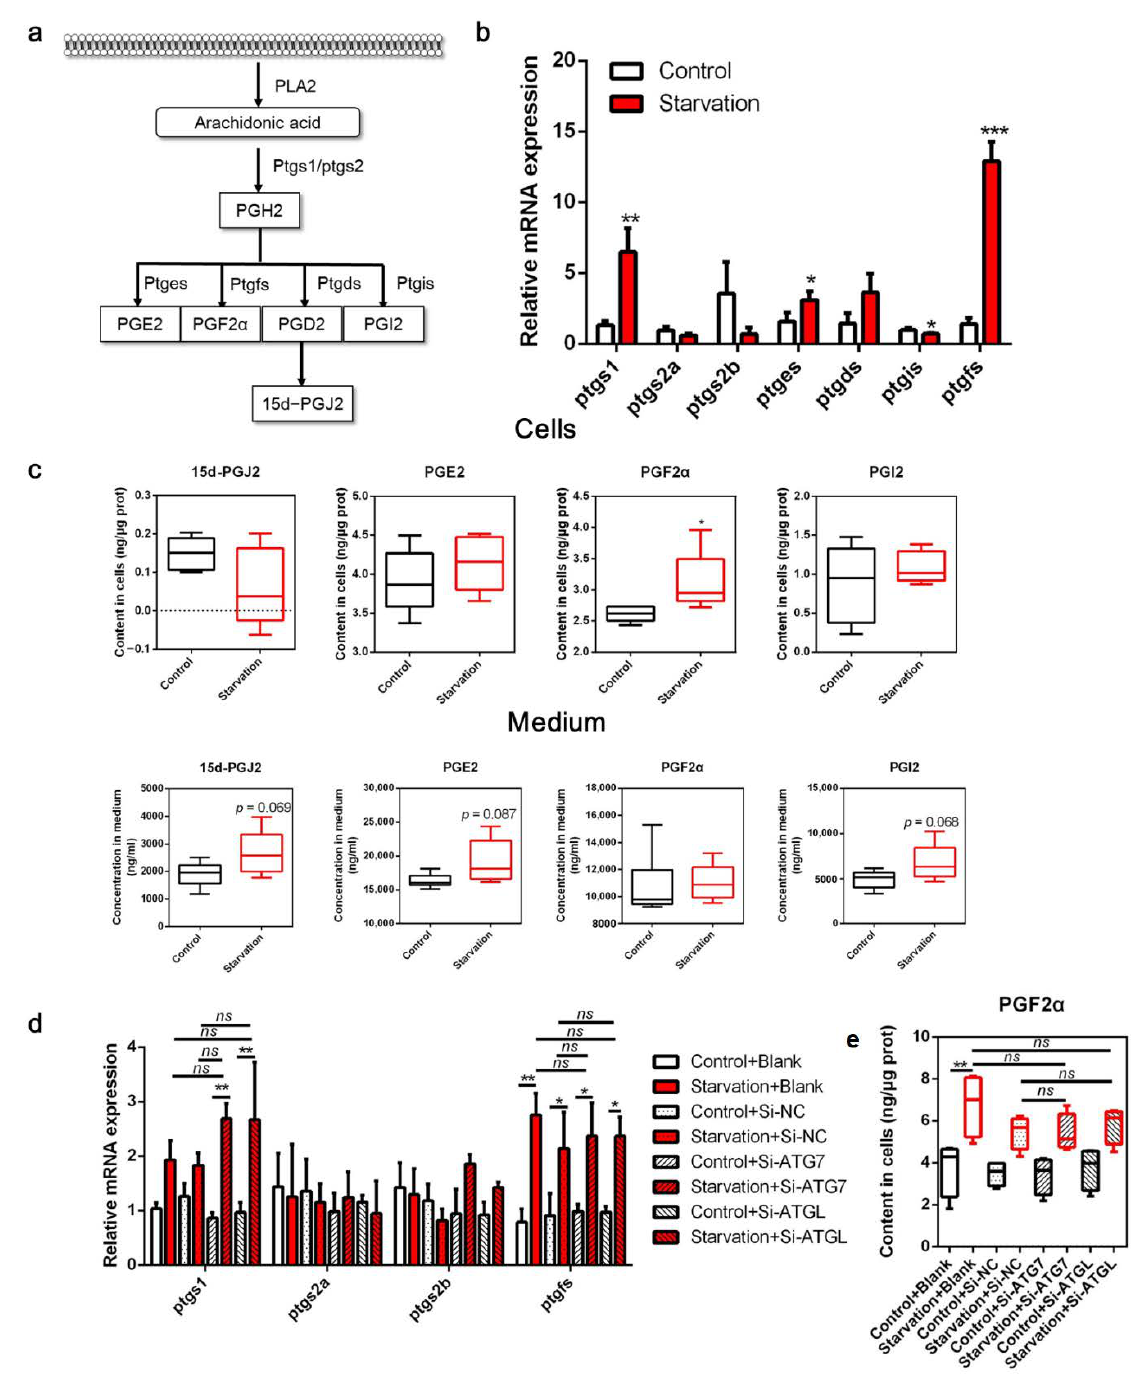
Figure 2. Effects of serum starvation on cyclooxygenase (COX) metabolism in zebrafish liver cells. ( a ) Schematic diagram of the COX pathway in arachidonic acid (ARA) metabolism. ( b , c ) Cells were incubated with either normal medium or serum-free medium for 24 h, and the relative transcript expression of COX metabolism-related genes ( n = 3) and the concentration of ARA-derived COX metabolites in the cells and medium were measured ( n = 5). ( d , e ) Cells were pre-treated with NC, ATG7, and ATGL siRNA and then serum-starved for 24 h, and the relative mRNA expression of COX metabolism-related genes ( n = 3) and the concentration of PGF2 α in cells ( n = 6) were measured. Ptgs, prostaglandin-endoperoxide synthase; pgtes, prostaglandin E synthase; ptgds, prostaglandin D2 synthase; ptgis, prostaglandin I2 synthase; ptgfs, prostaglandin F synthase. Statistical significance is denoted with asterisks as follows: * p < 0.05; ** p < 0.01; *** p < 0.001; ns, not significant